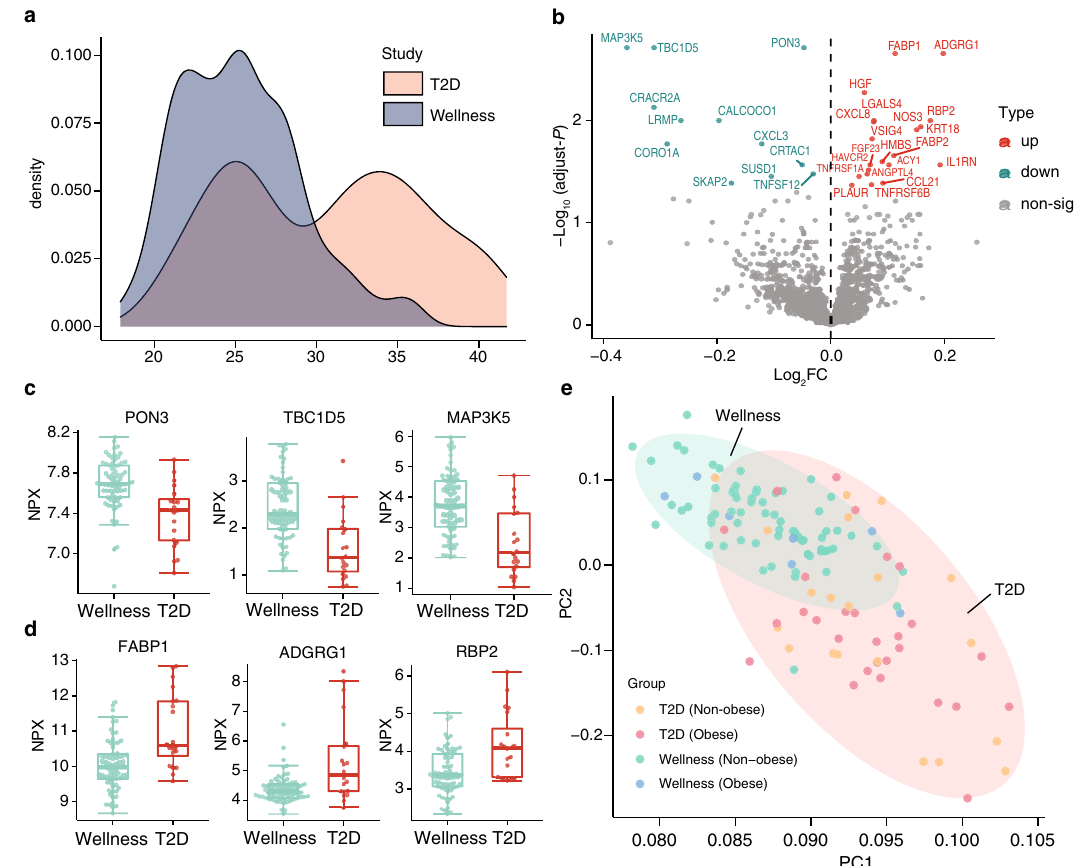
Fig. 5 Plasma proteins associated with type 2 diabetes. a The distribution of body mass index (BMI) in the two cohorts. b A volcano plot showing the differentially expressed proteins at baseline in the non-obesity group in T2D and wellness cohorts. The X -axis represents log 2 fold-change (FC) and the Y -axis represents log P -values). Differentially expressed proteins were de fi ned as proteins with adjusted P -values < 0.05 (two-way balanced 10 (adjusted ANOVA for study cohort with gender as covariate). Multiple test corrections have been applied for P -values using Benjamini and Hochberg method. c Three examples of the upregulated proteins in the non-obesity T2D patients compared to the non-obesity healthy individuals in the wellness cohort. Box plots show medians and the 25th and 75th percentiles, whiskers show the largest and smallest values ( n = 89 samples), error bars represent mean ± SD. d Three examples of the down-regulated proteins in the non-obesity T2D patients. e PCA results presenting the expression patterns of healthy and disease individuals at baseline based on the protein pro fi les of differentially expressed proteins between the non-obesity groups in T2D and wellness cohorts. Source data are provided as a Source Data fi